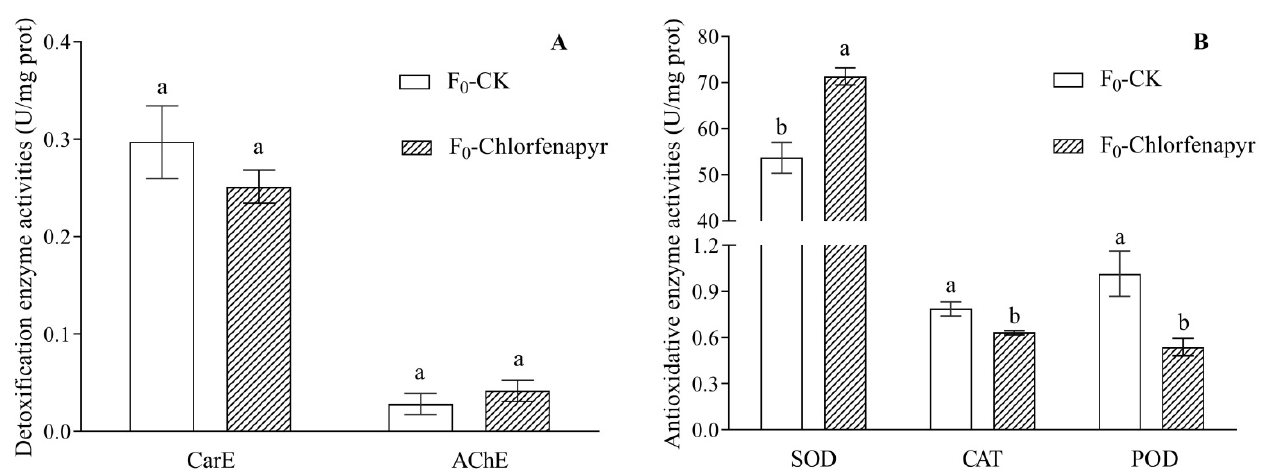
Figure 7. Effects of chlorfenapyr on detoxification enzyme ( A ) and antioxidative enzyme ( B ) activities of P . marginatus (F 0 -Chlorfenapyr) and F 0 -CK. Data are means ± SE of three biological replications; different letters above each bar indicate statistically significant difference by t -test ( p < 0.05). CK represents the control, AchE is acetylcholinesterase, CarE is carboxylesterase, SOD is superoxide dismutase, CAT is catalase, and POD is peroxidase.